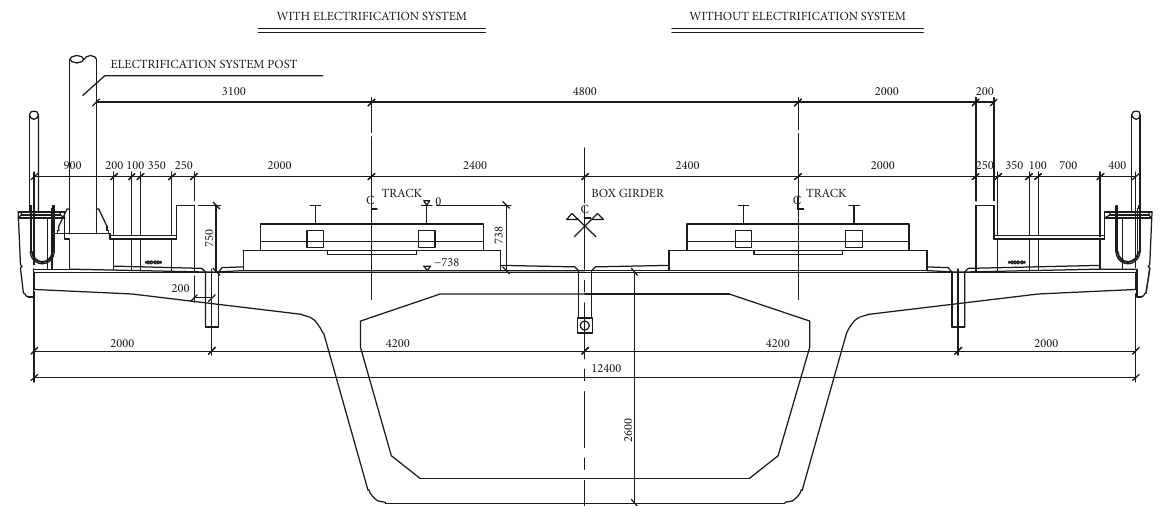
Figure 4: Cross-section of the box beam at the middle span (unit: mm).